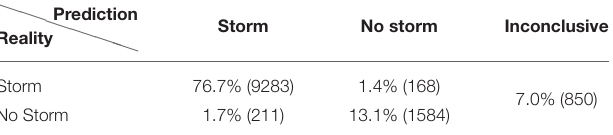
TABLE 7 | FNN 2 using V / I only.